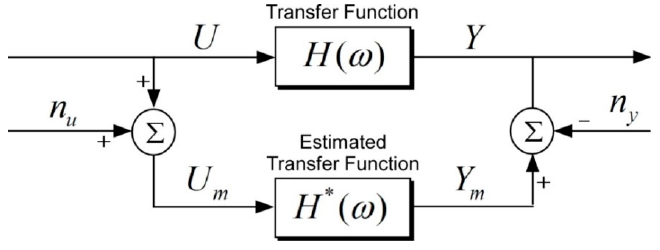
Figure 14. Frequency-domain identification of linear systems.